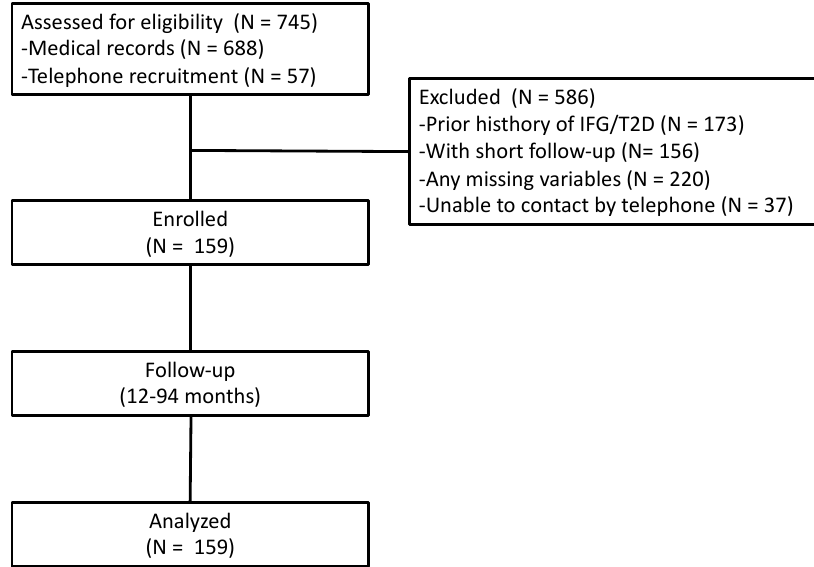
Figure 1. Flowchart of the participants in the study. IFG, impaired fasting glucose; T2D, type 2 diabetes.